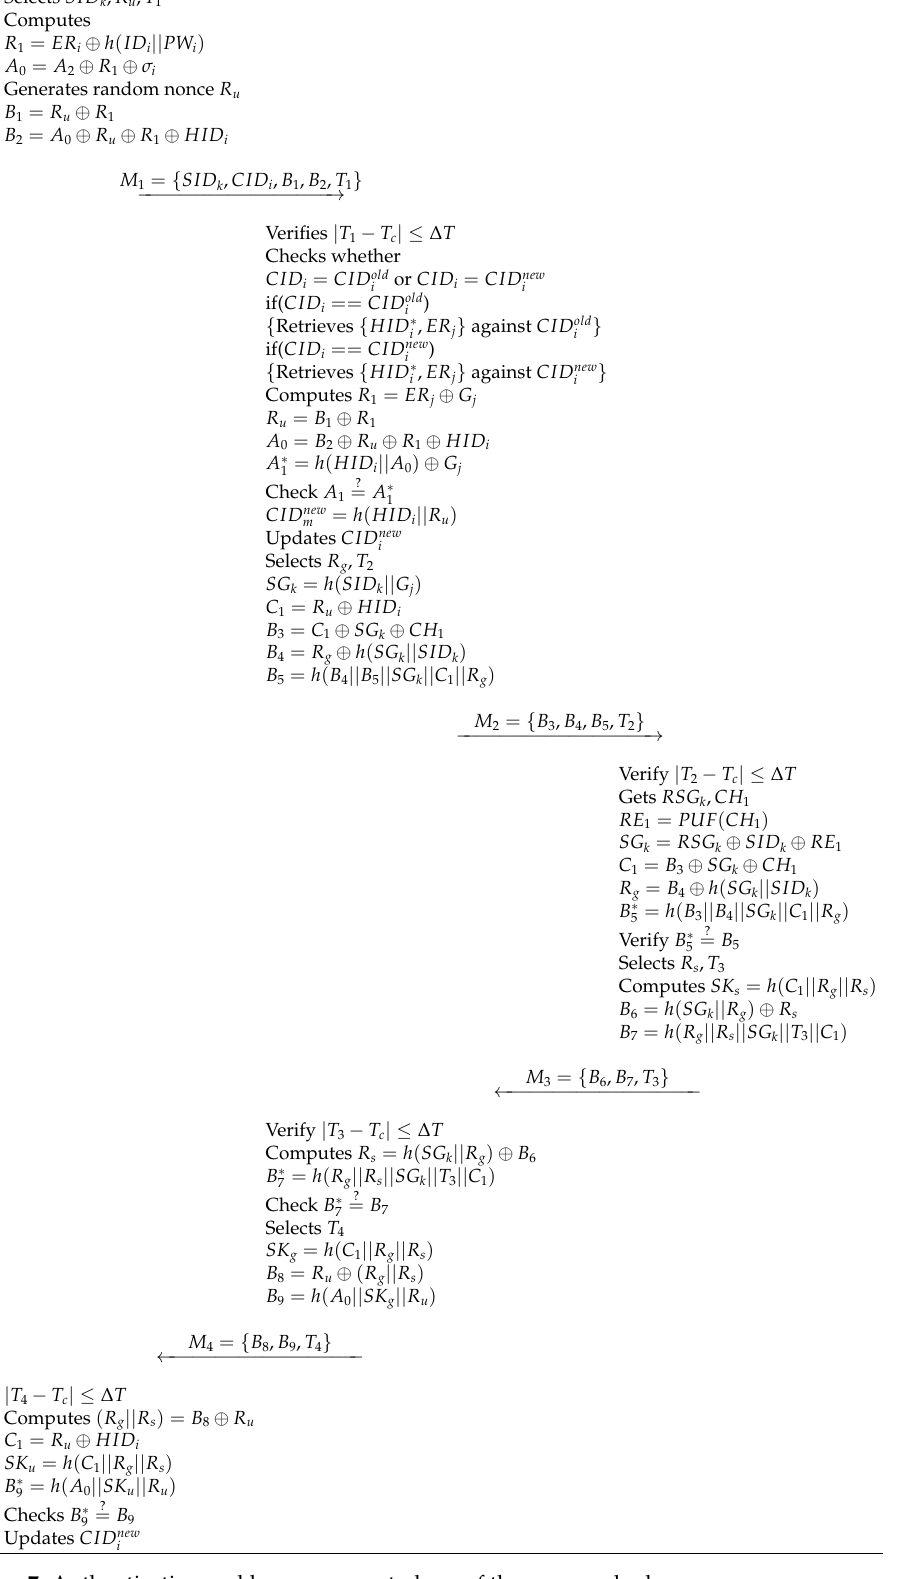
Figure 7. Authentication and key agreement phase of the proposed